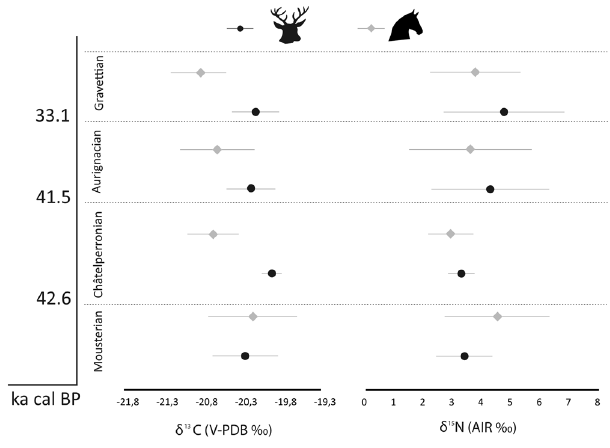
Figure 2. Mean red deer (denoted by black circles) and horse (denoted by grey diamonds) values with error bars showing 1 σ for each cultural period. The chronological data are from Marín-Arroyo et al . 33 which states that the Mousterian disappeared in the region by 47.9–45.1ka cal BP, while the Châtelperronian lasted between 42.6k and 41.5ka cal BP and the Mousterian and Châtelperronian did not overlap. The Aurignacian appears between 43.3–40.5ka cal BP overlapping with the Châtelperronian and ended around 34.6–33.1ka cal BP, after the Gravettian had already been established in the region.